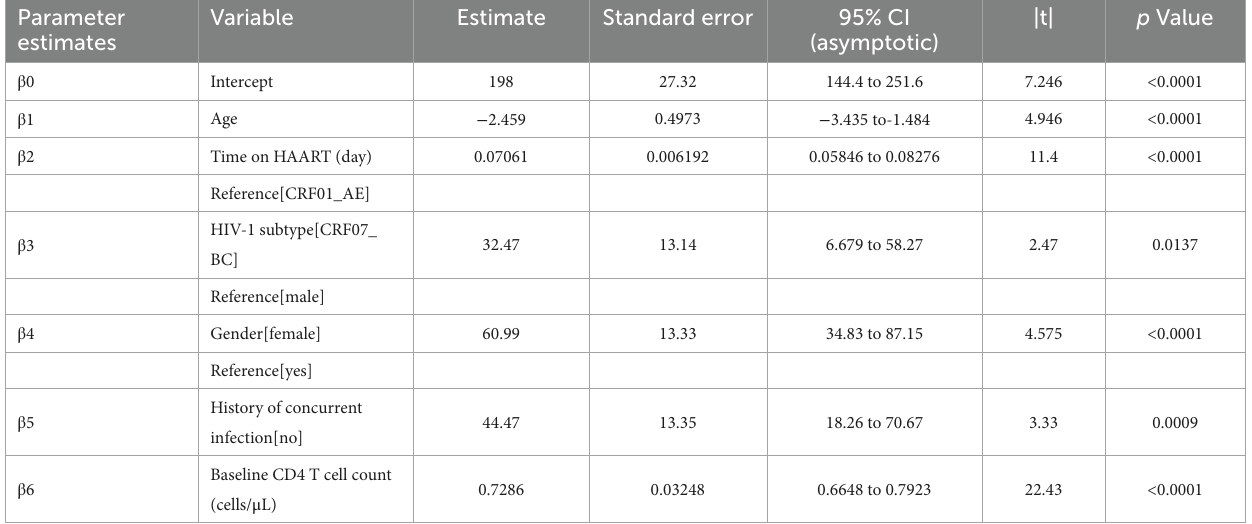
TABLE 7 Factors associated with CD4 + T cell count during